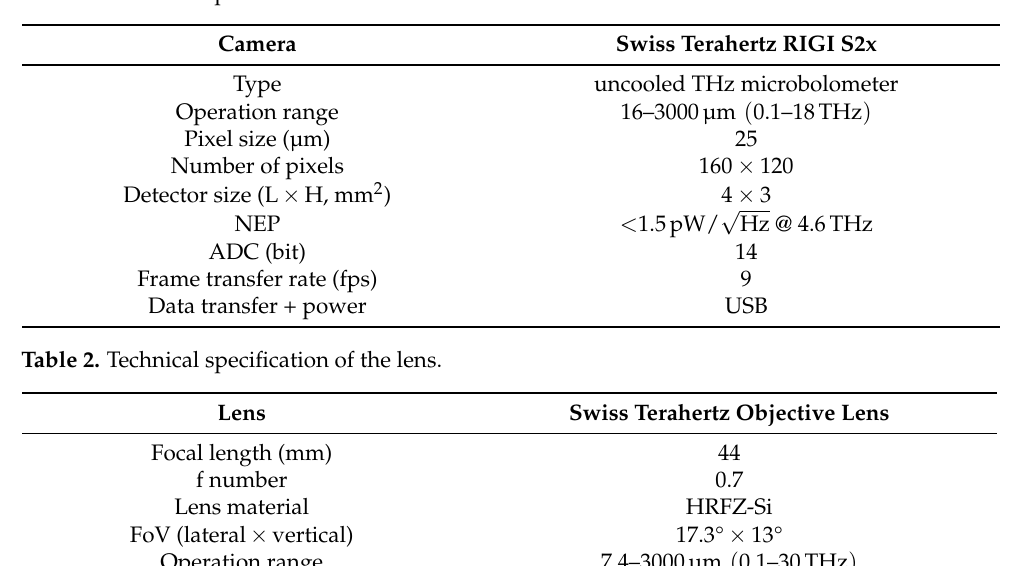
Table 1. Technical specification of the camera.